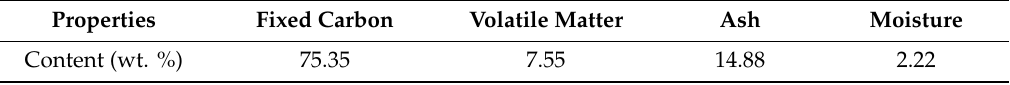
Table 1. Chemical analysis of the reductant (air